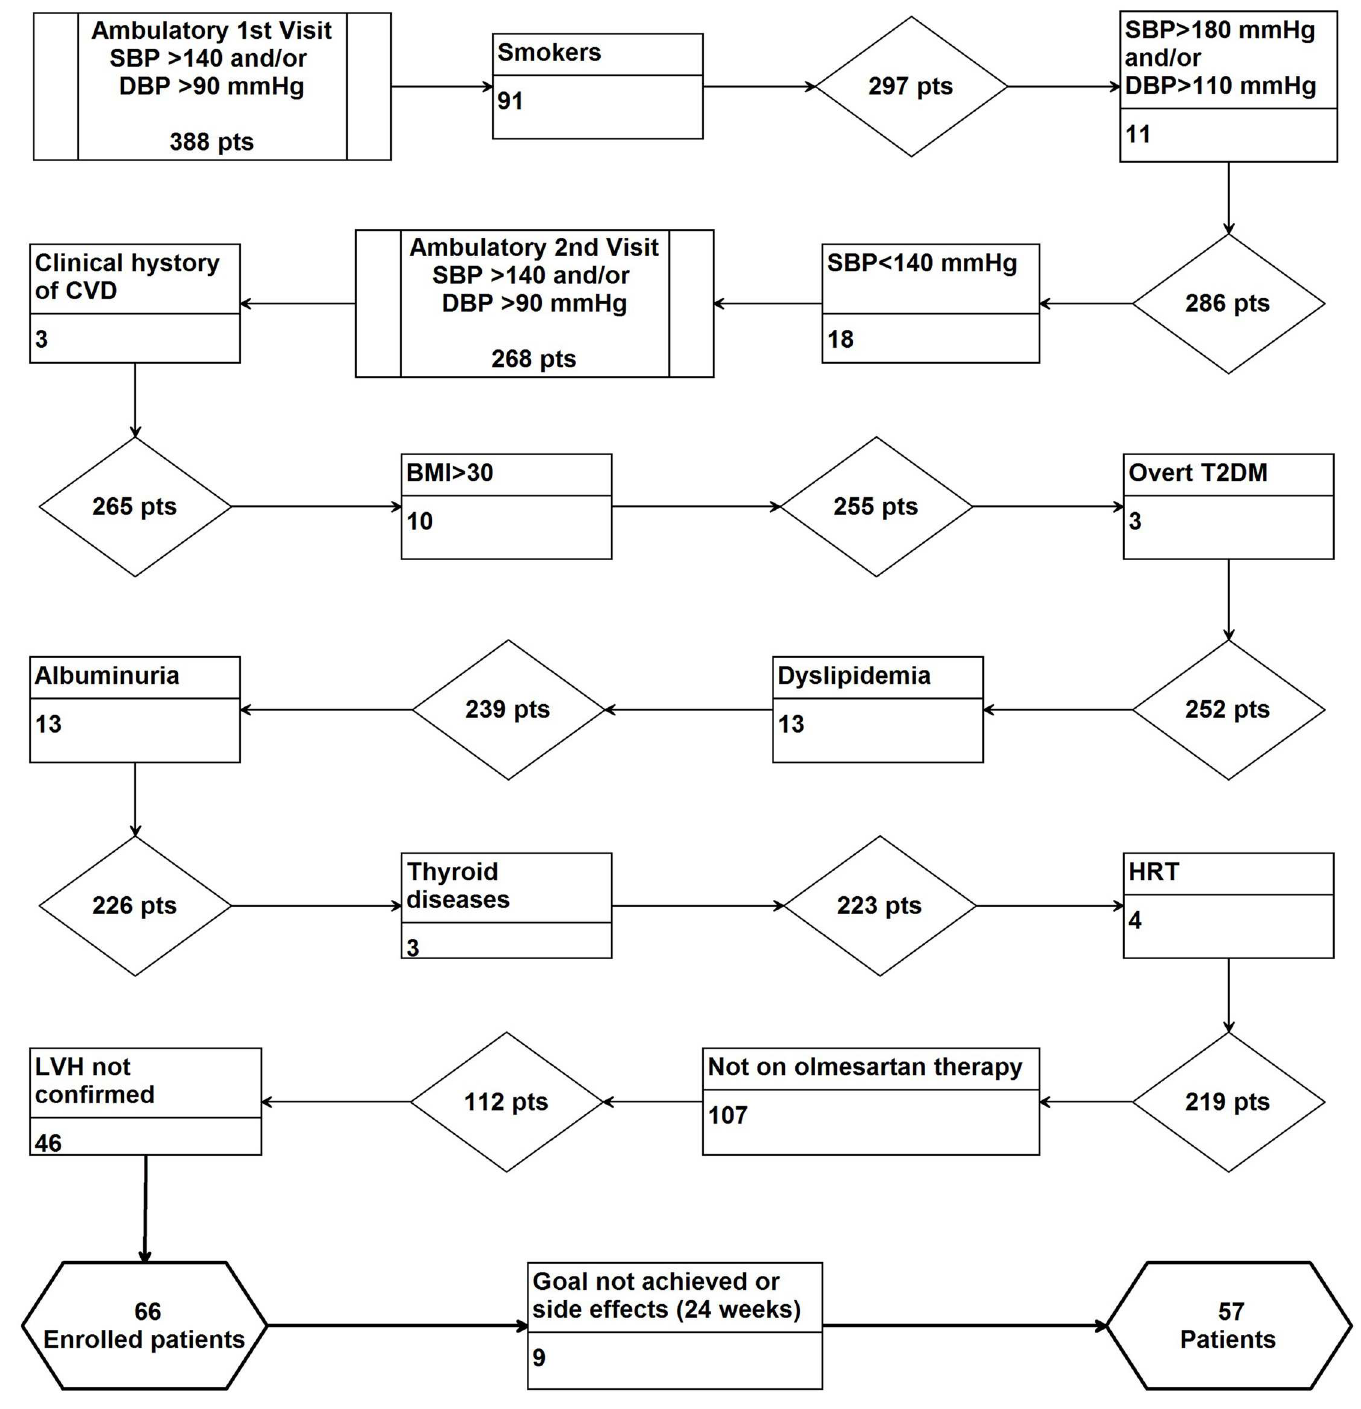
Fig 1. Flow diagram for patient